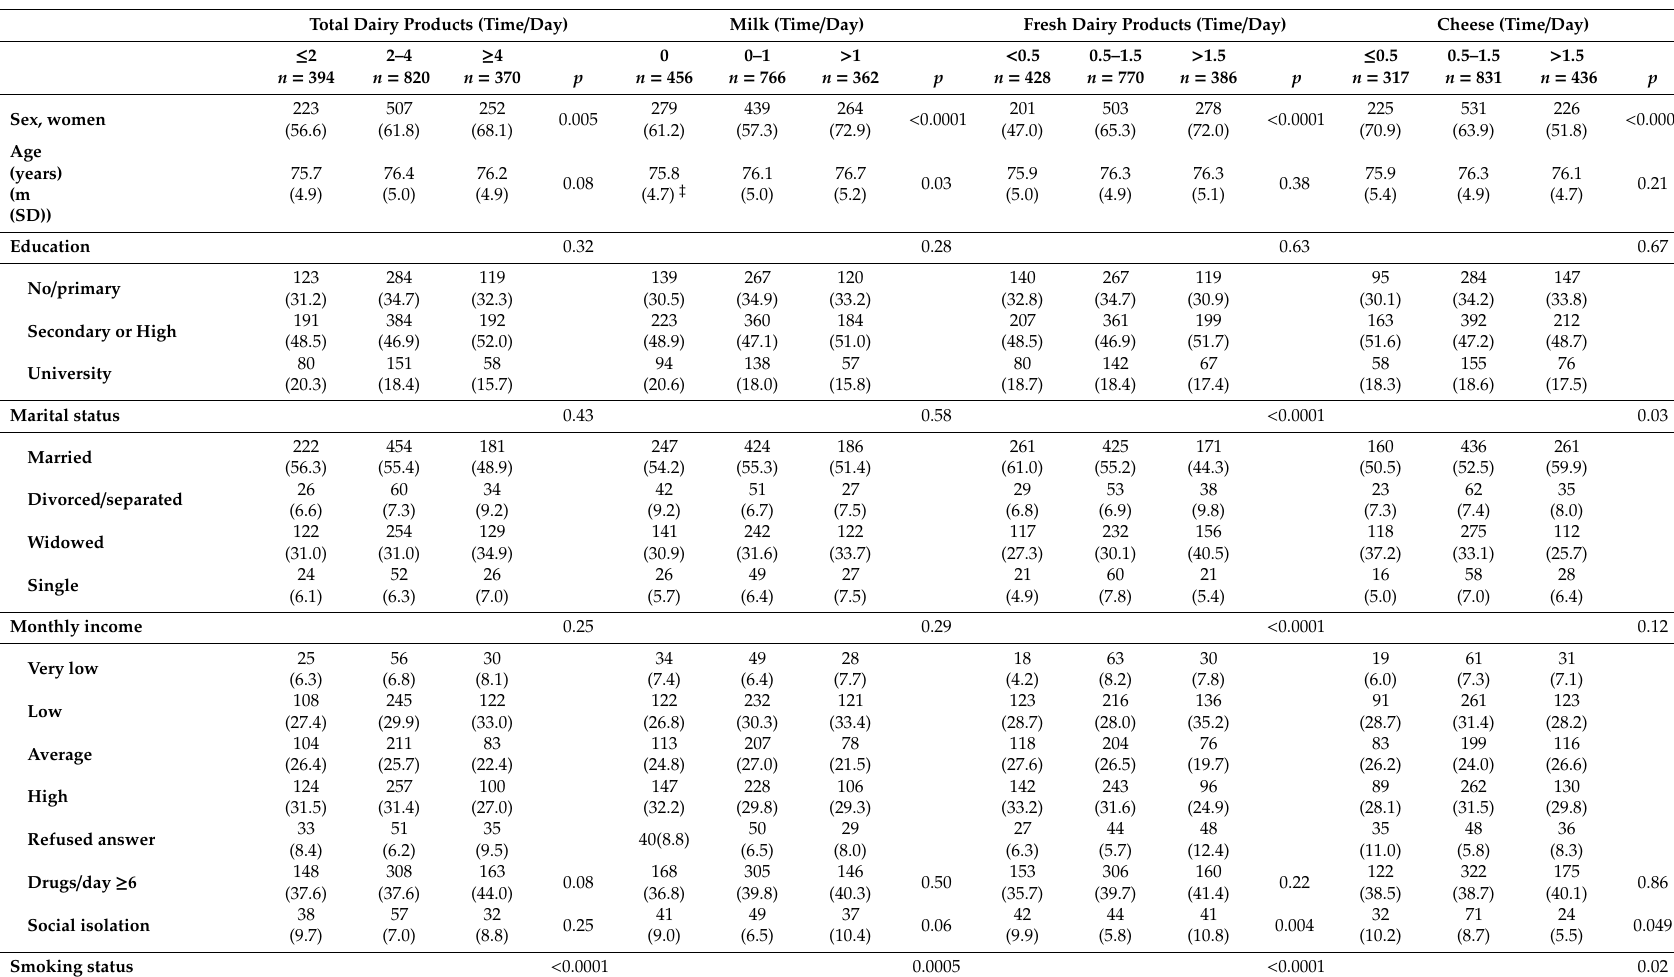
Table 1. Socio-demographic and lifestyle characteristics across increasing daily frequency consumption of dairy products among elderly community dwellers from the 3C study, Bordeaux (France), 2001–2002, n =